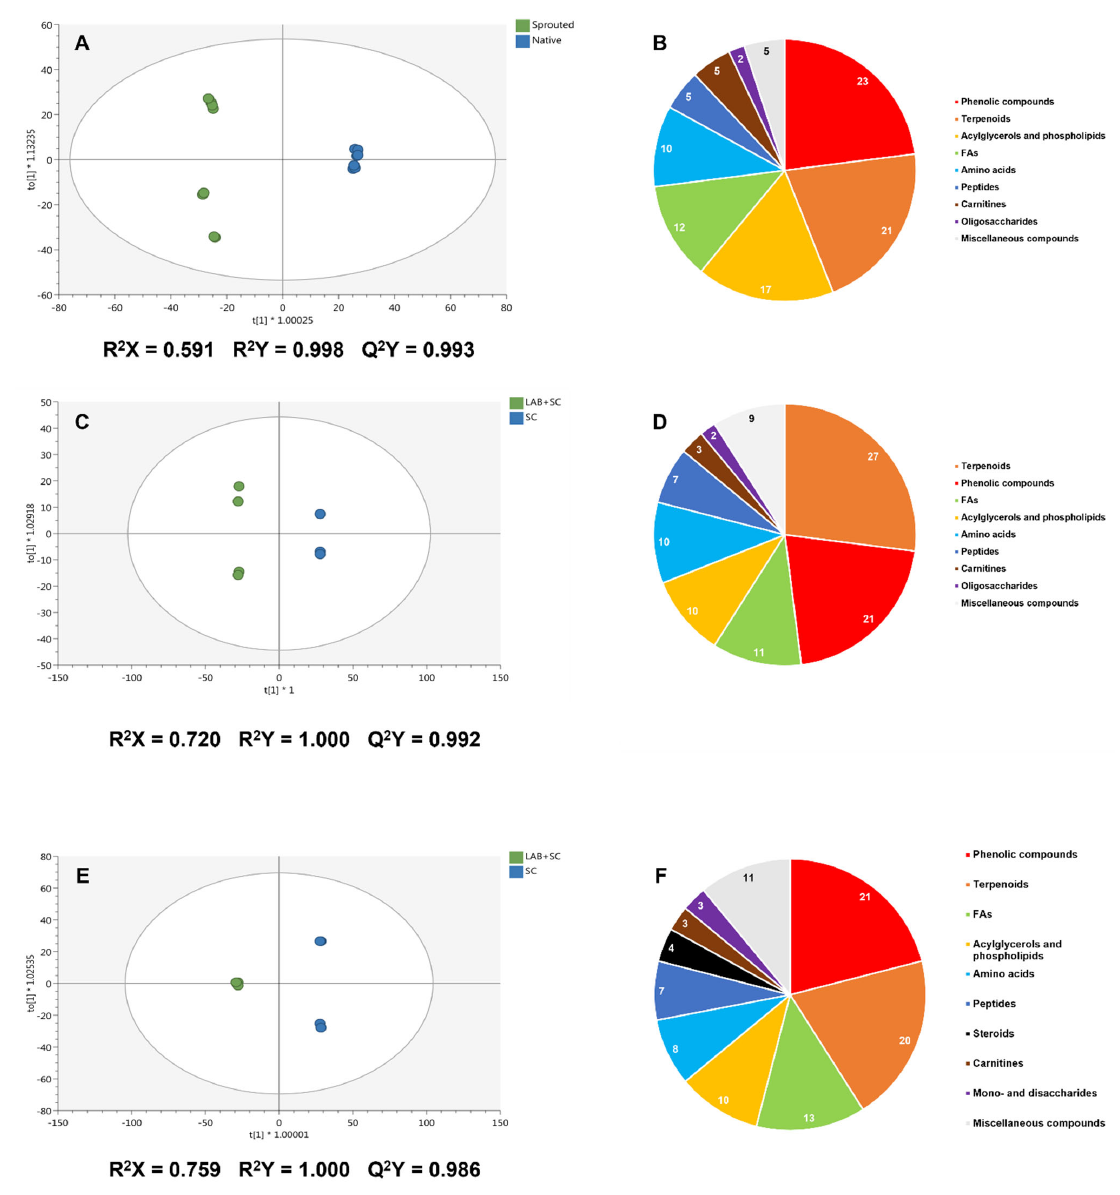
Figure 6. Orthogonal projection to latent structures discriminant analysis and variable importance in projection analysis of rye doughs. The OPLS models were combined with the proportion of VIP markers on the discrimination of metabolomic effects caused by germination conditions ( A , B ), fermentation starters on native rye doughs ( C , D ), fermentation starters on sprouted rye doughs ( E , F ).